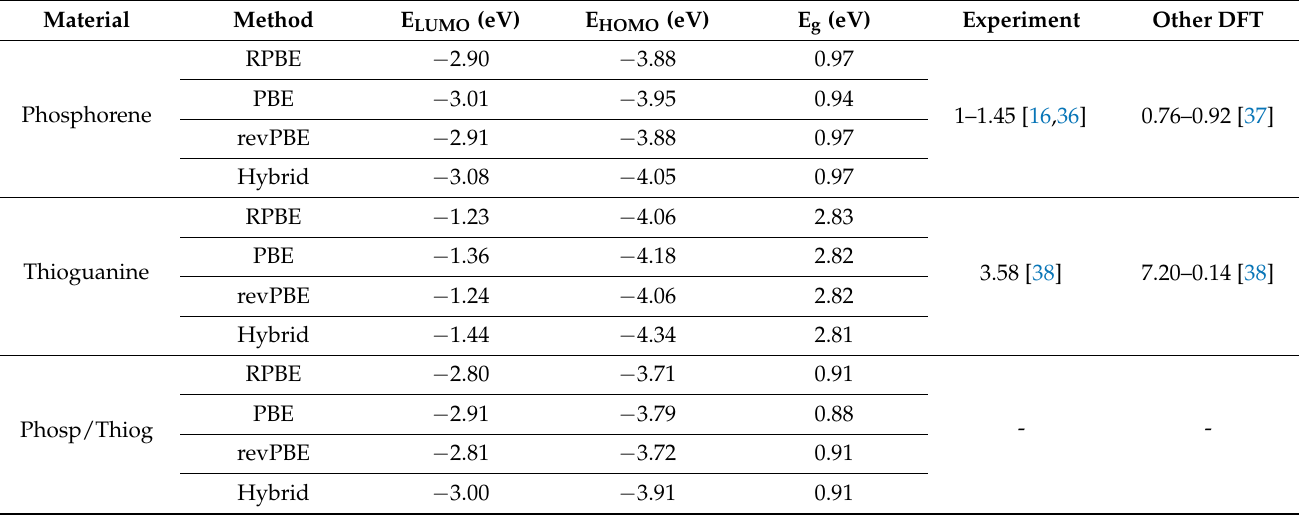
Table 1. The calculated values of HOMO, LUMO energy level, and energy gap (E g ) all in (eV) of phosphorene, thioguanine, and their